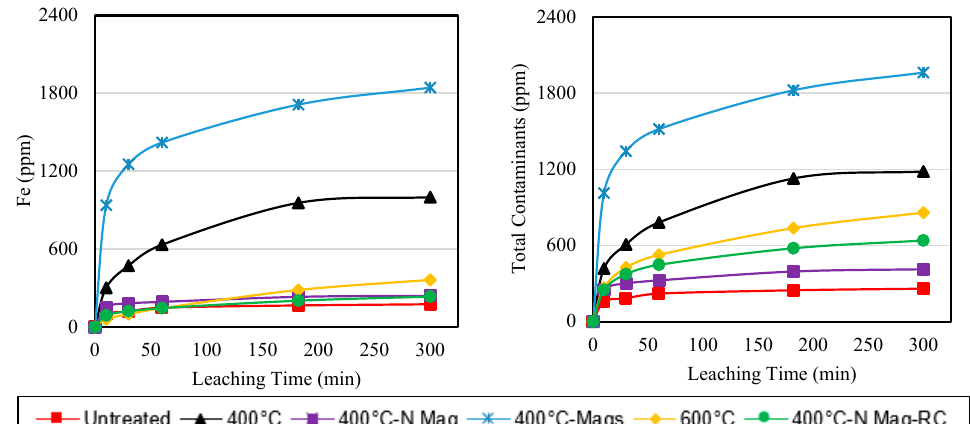
Figure 10. Acid leaching test results with 1.2M H 2 SO 4 for the 2.20 SG sink calcined products at different temperatures. (Mags = Magnetic; N. Mag = Non-magnetic; N. Mag-RC = Non-magnetic fraction re-calcined at 600 °C).